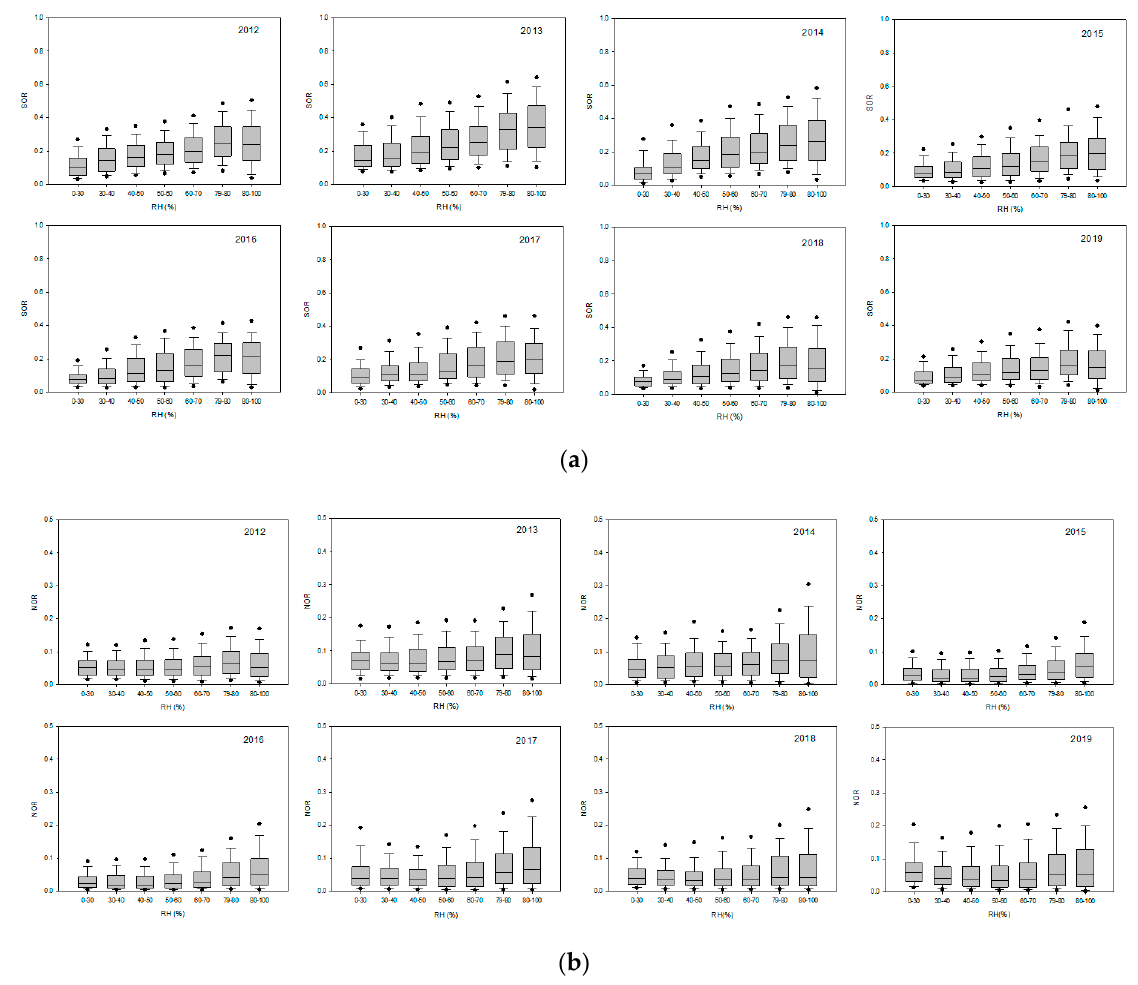
Figure 11. Changes in the SOR and NOR according to RH in Seoul: ( a ) SOR; ( b ) NOR. Table 5. The annual equivalent ratio on Baengnyeong